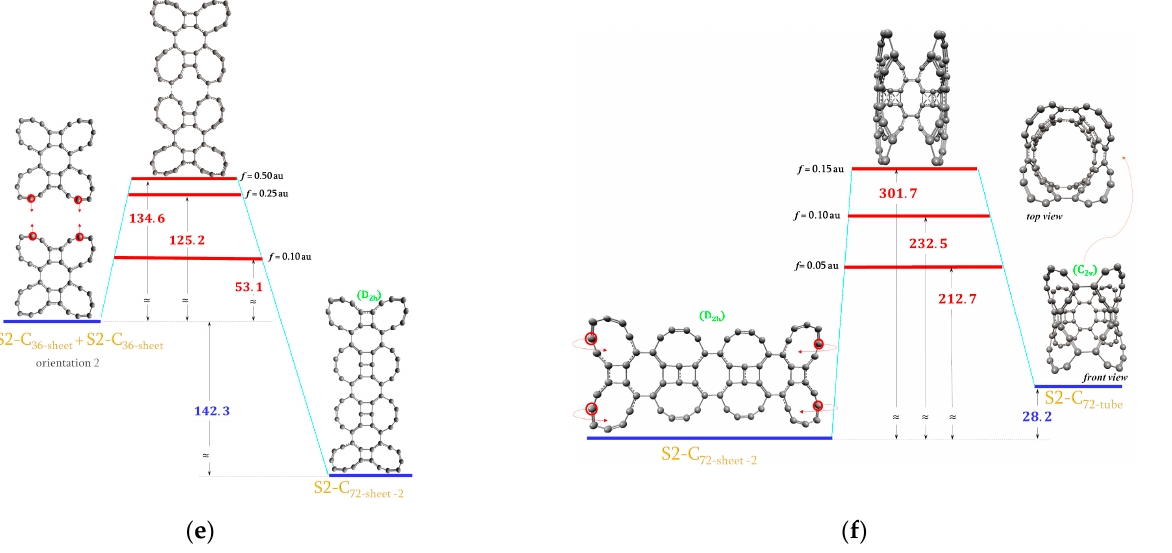
Figure 7. The energy diagram with the estimated upper limit of the energy demand for the formation of the ( a ) S2-C 36-ribbon-2 molecule; ( b ) S2-C 72-ribbon molecule; ( c ) S2-C 36-sheet molecule; ( d ) S2-C 72-sheet-1 molecule; ( e ) S2-C 72-sheet-2 molecule; ( f ) S2-C 72-tube molecule. All values are in kcal/mol.